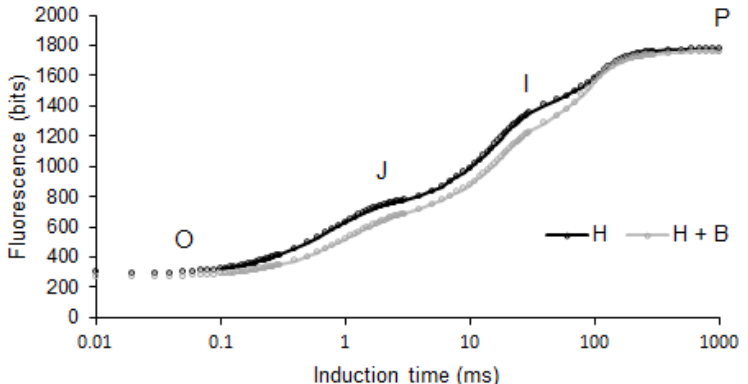
Figure 4. Native fluorescence induction curves of sunflower plants subjected to the treatments (H: Pulsar-40; H + B: Pulsar-40 + Terra Sorb ® foliar). Represented values are means from nine data ( n = 9).